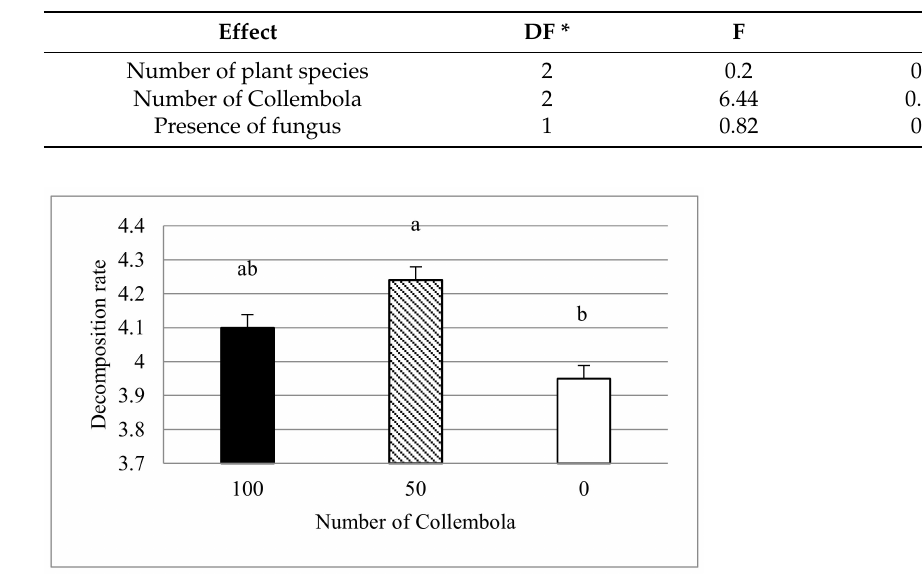
Figure 5. The decomposition rate in three variants of Collembola number (100, 50, and 0 individuals). The different lowercase letters indicate significant differences between treatments, p ≤